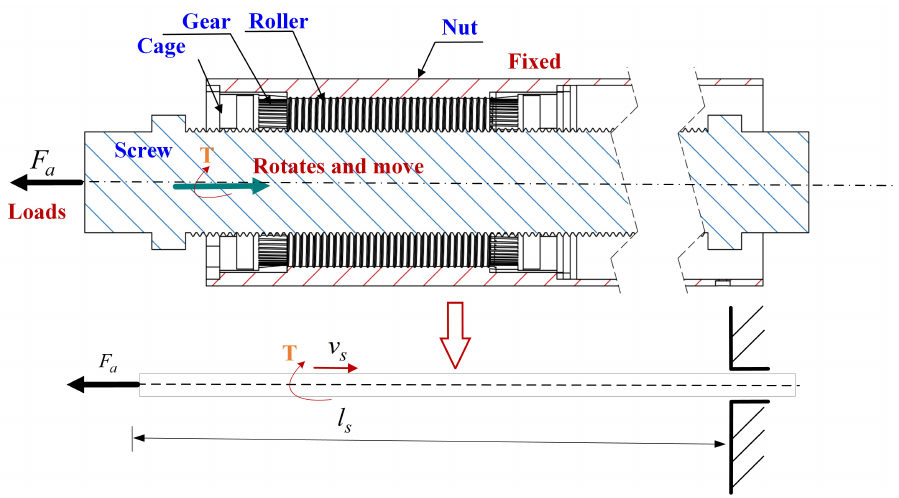
Figure 5. The diagram of the deformation in case